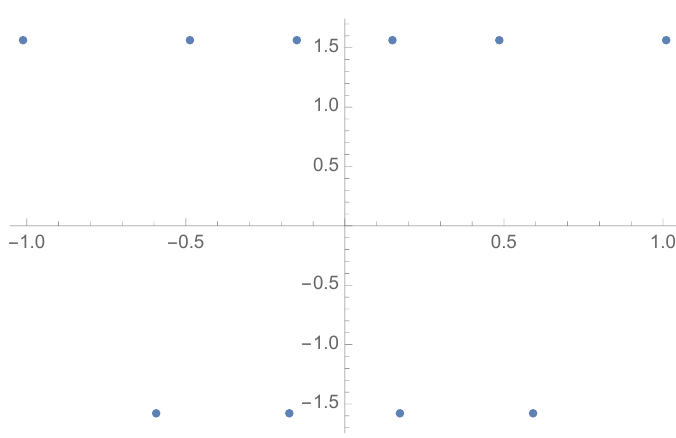
Figure 19 . An example of a solution to the bulk BAE that leads to a continuum state. This example corresponds to L = 12 , with n + = 0 and n − = 2 .